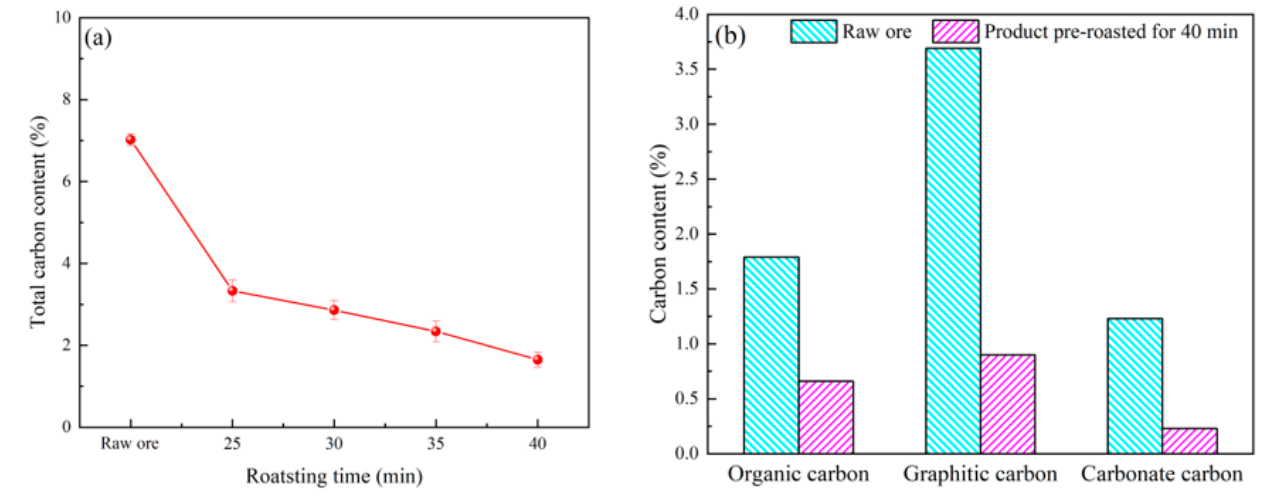
Figure 4. ( a ) The carbon content of the pre-roasted products and ( b ) carbon chemical-phase analysis results of the raw ore and the product pre-roasted for 40 min. Table 4. Carbon chemical phase analysis results of the product pre-roasted for 40 min. Phase Organic